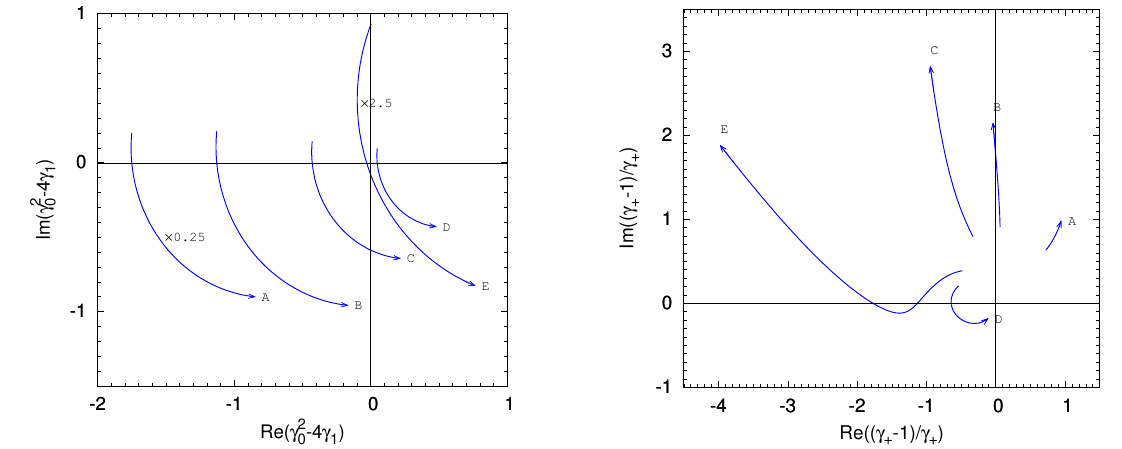
Figure 3. Trajectories of eq. (5.49) for the (cid:12)ve con(cid:12)gurations of table 1. In the left panel, trajectories relevant to con(cid:12)gurations A and E are multiplied by the numerical factors reported in the labels in order for them to (cid:12)t into the layout, and to improve visibility; note that < ( T ((cid:22) (cid:13) = 0)) > 0 for con(cid:12)guration